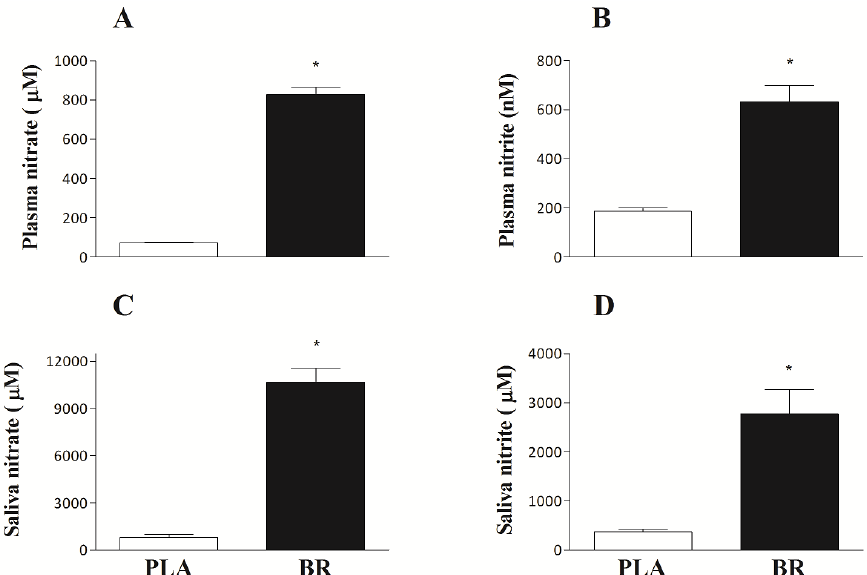
Figure 1. Mean plasma nitrate ( A ) and nitrite ( B ), and saliva nitrate ( C ) and nitrite ( D ) concentrations ~2.5 h after ingestion of the final supplemental bolus for the placebo (PLA) and the six-day nitrate-rich beetroot juice (BR) intervention. Data are means ± SEM ( n = 32). * BR significantly different from PLA ( p < 0.001).